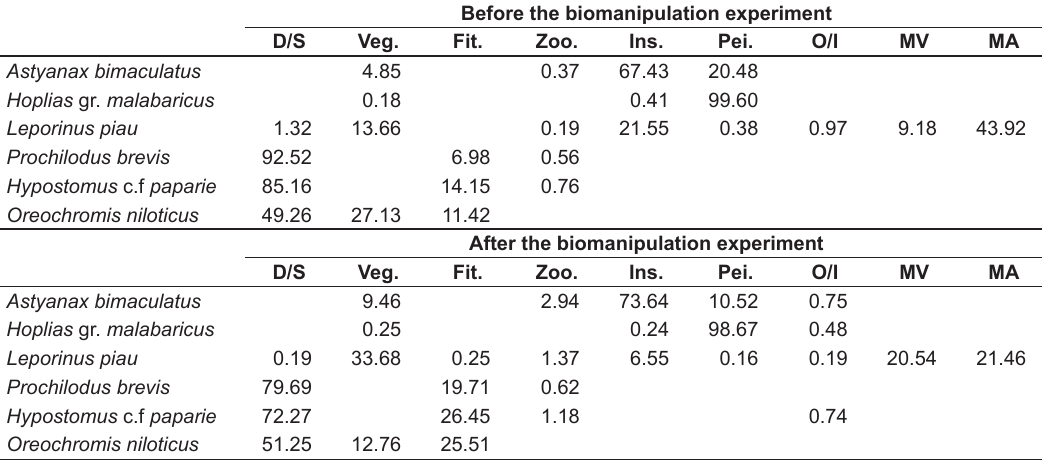
Table 2. Feeding Index (IAi) of fish species studied at the Estação Ecológica do Seridó (ESEC-Seridó), Serra Negra, Rio Grande do Norte, Brazil, before and after the